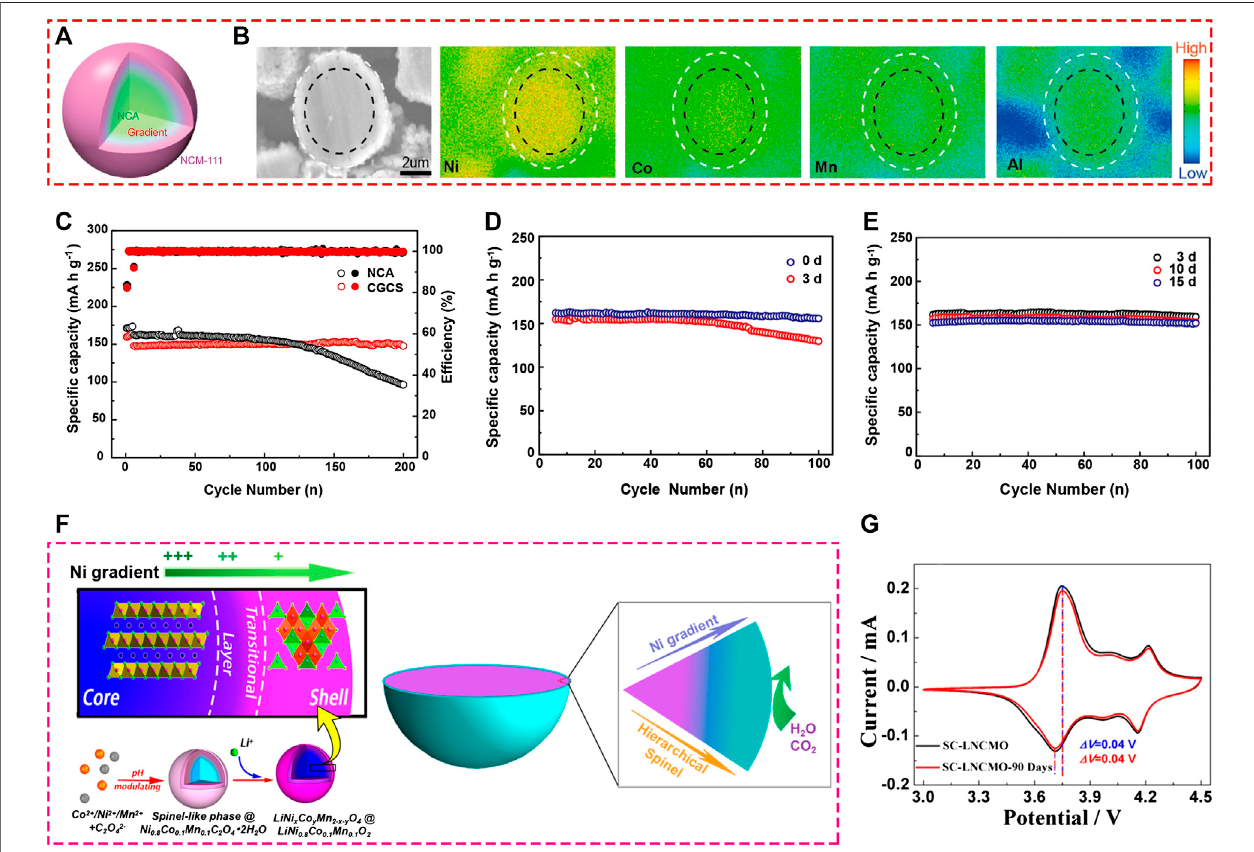
FIGURE 7 | (A) Schematic view of the concentration-gradient core-shell structure cathode (CGCS) material; (B) Cross-sectional image of CGCS and correspondingelementmaps ofNi,Co,Mn,and Al; (C) Cyclingperformancecomparison ofpristineNCA andCGCS between3.0and4.3V;Cyclingperformanceof (D) pristine NCA and (E) CGCS after air exposure witha relative humidity ofabout 30%for differentnumbers of days between 3.0 and 4.3 V. Adapted from [Shiet al., 2017] with permission from American Chemical Society. (F) Schematic view of the core-shell structure and preparation process of gradient Ni-rich cathode material; (G) CV curves for gradient Ni-rich cathode material before and after 90-days air exposure. Adapted from [Zhang et al., 2017] with permission from American Chemical Society.